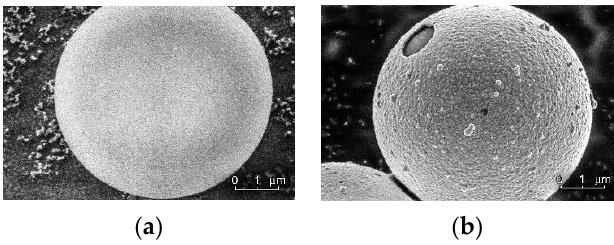
Figure 1. SEM photographs of a spherical monodisperse melamine-formaldehyde (MF) particle: ( a ) with a diameter of 9.95 μm, without coating; ( b ) with a 200-nm-thick copper coating.